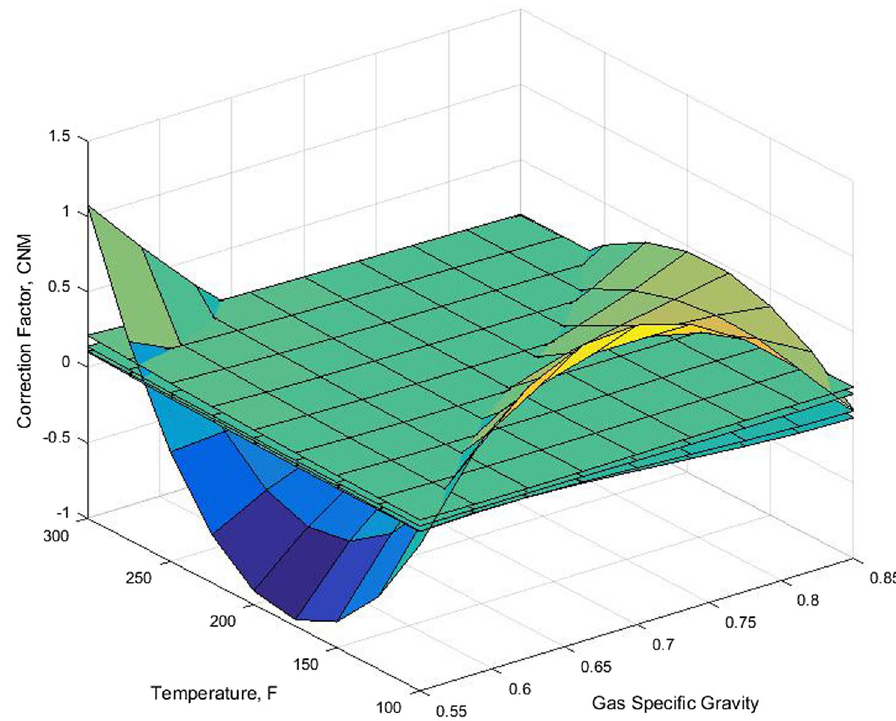
Fig. 15 Isobar plot for natural gases in Table 1 at different pressure conditions